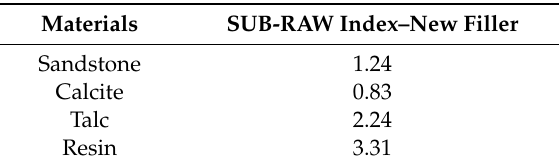
Table 4. SUB-RAW Indices were calculated comparing the obtained composite using stabilized FA sample with other